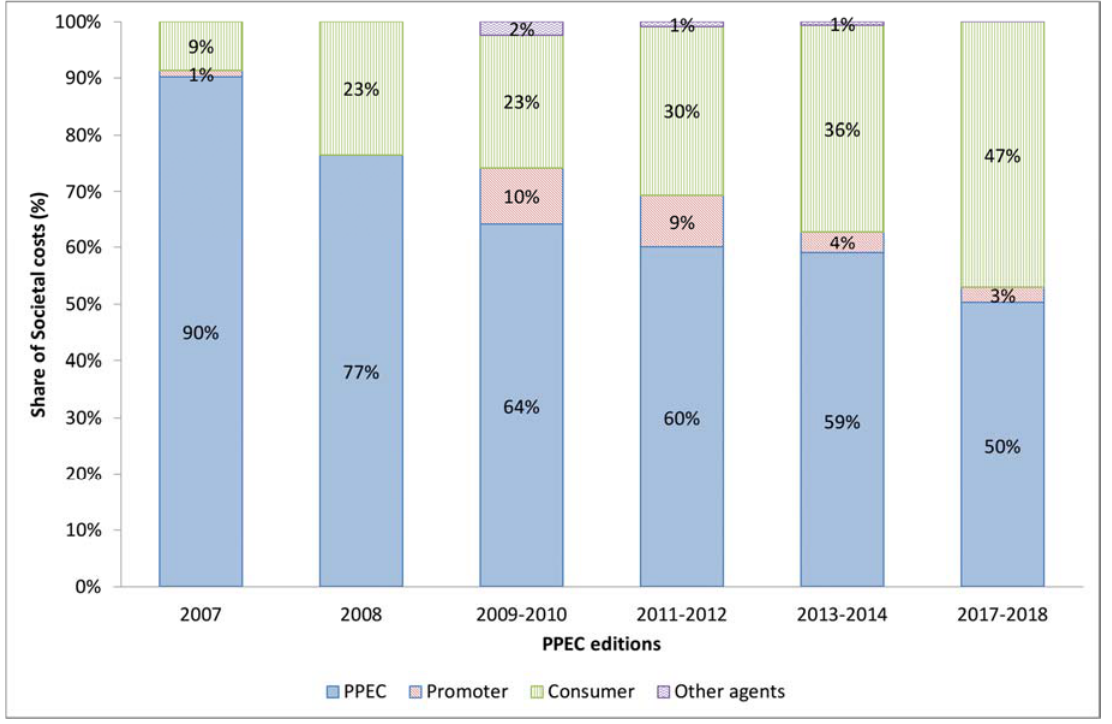
Figure 8. Share of societal costs of the selected tangible measures in each PPEC edition [19–26].